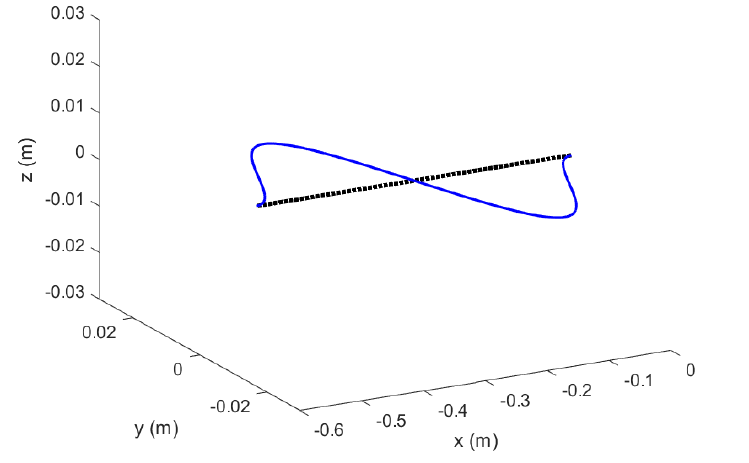
Figure 7. Mode 2 (in–plane/lead–lag) of two Euler–Bernoulli Beams connected through hinged joint.